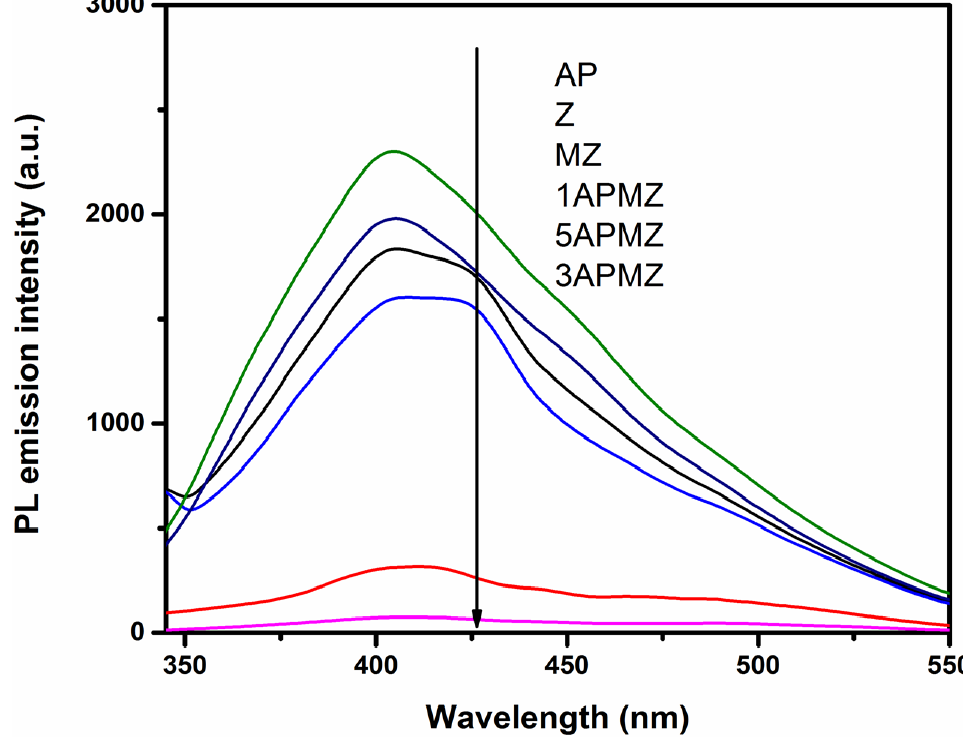
Figure 6. PL analysis of all the samples in the range of wavelength 345 nm to 550 nm at 325 nm excitation